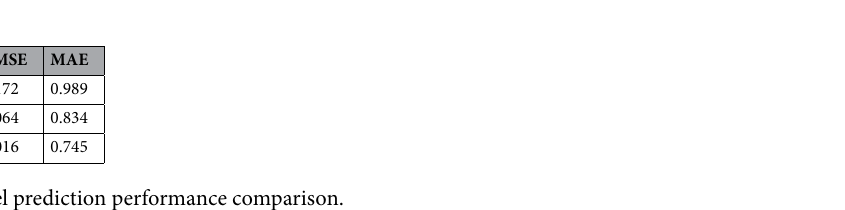
Table 11. Model prediction performance